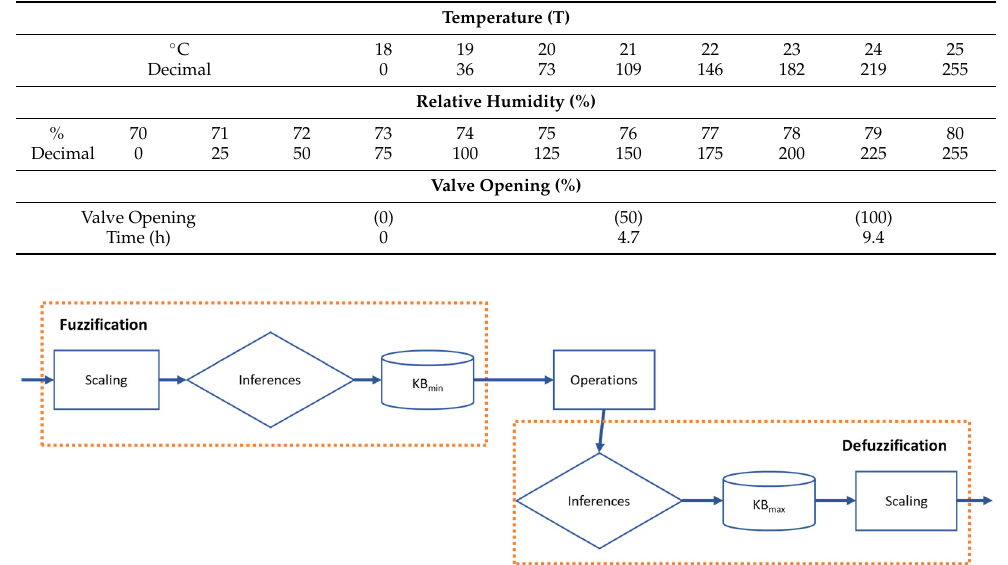
Table 1. Summary of variables in their decimal equivalent: environmental temperature (T), relative humidity (RH), and valve opening.